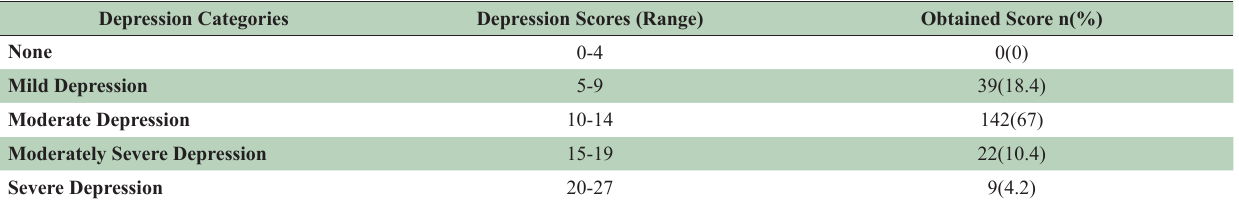
Table-III: Association of SNS parameters between male and female students.